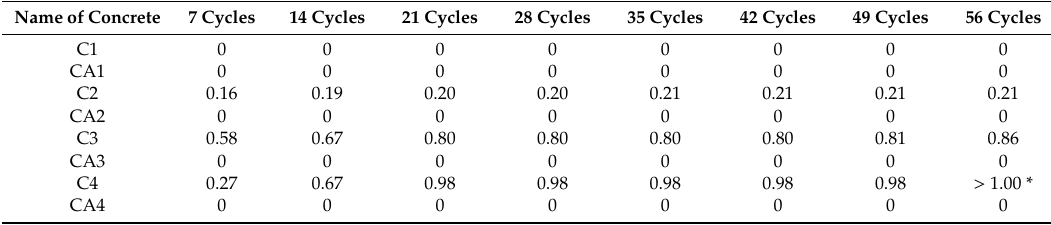
Table 6. The decrease in mass after scaling with de-icing salt after di ff erent numbers of freeze–thaw cycles (kg / m 2